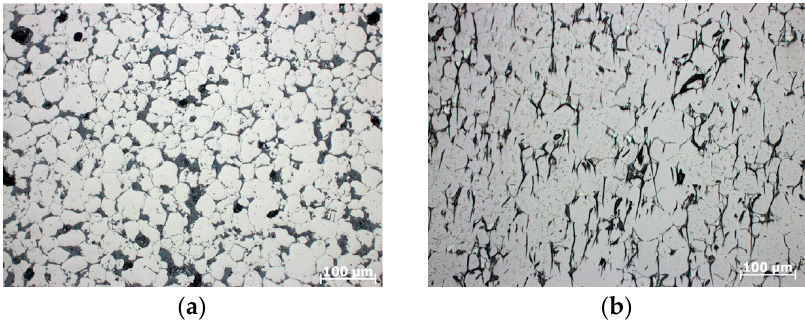
Figure 7. Microstructure of TiC-50% Ti synthesized powder sintered at: ( a ) 1300 °C and ( b ) 1350 °C.